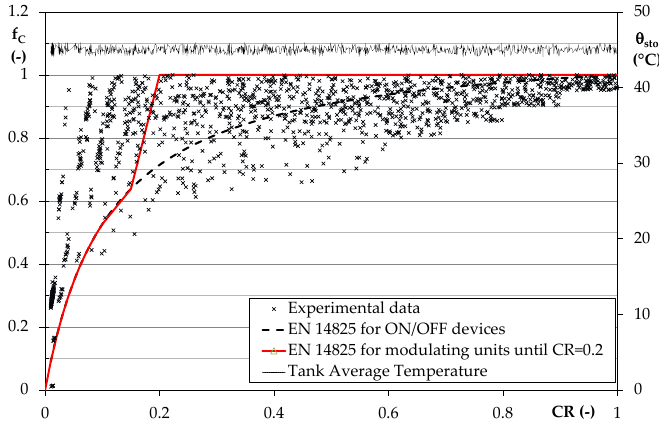
Figure 5. Average tank temperature and correction factors f C determined in the winter from the experimental data and a comparison with the trends obtained by applying the EN 14825 procedure for an ON-OFF device and a heat pump with a minimal modulation value of 0.2.